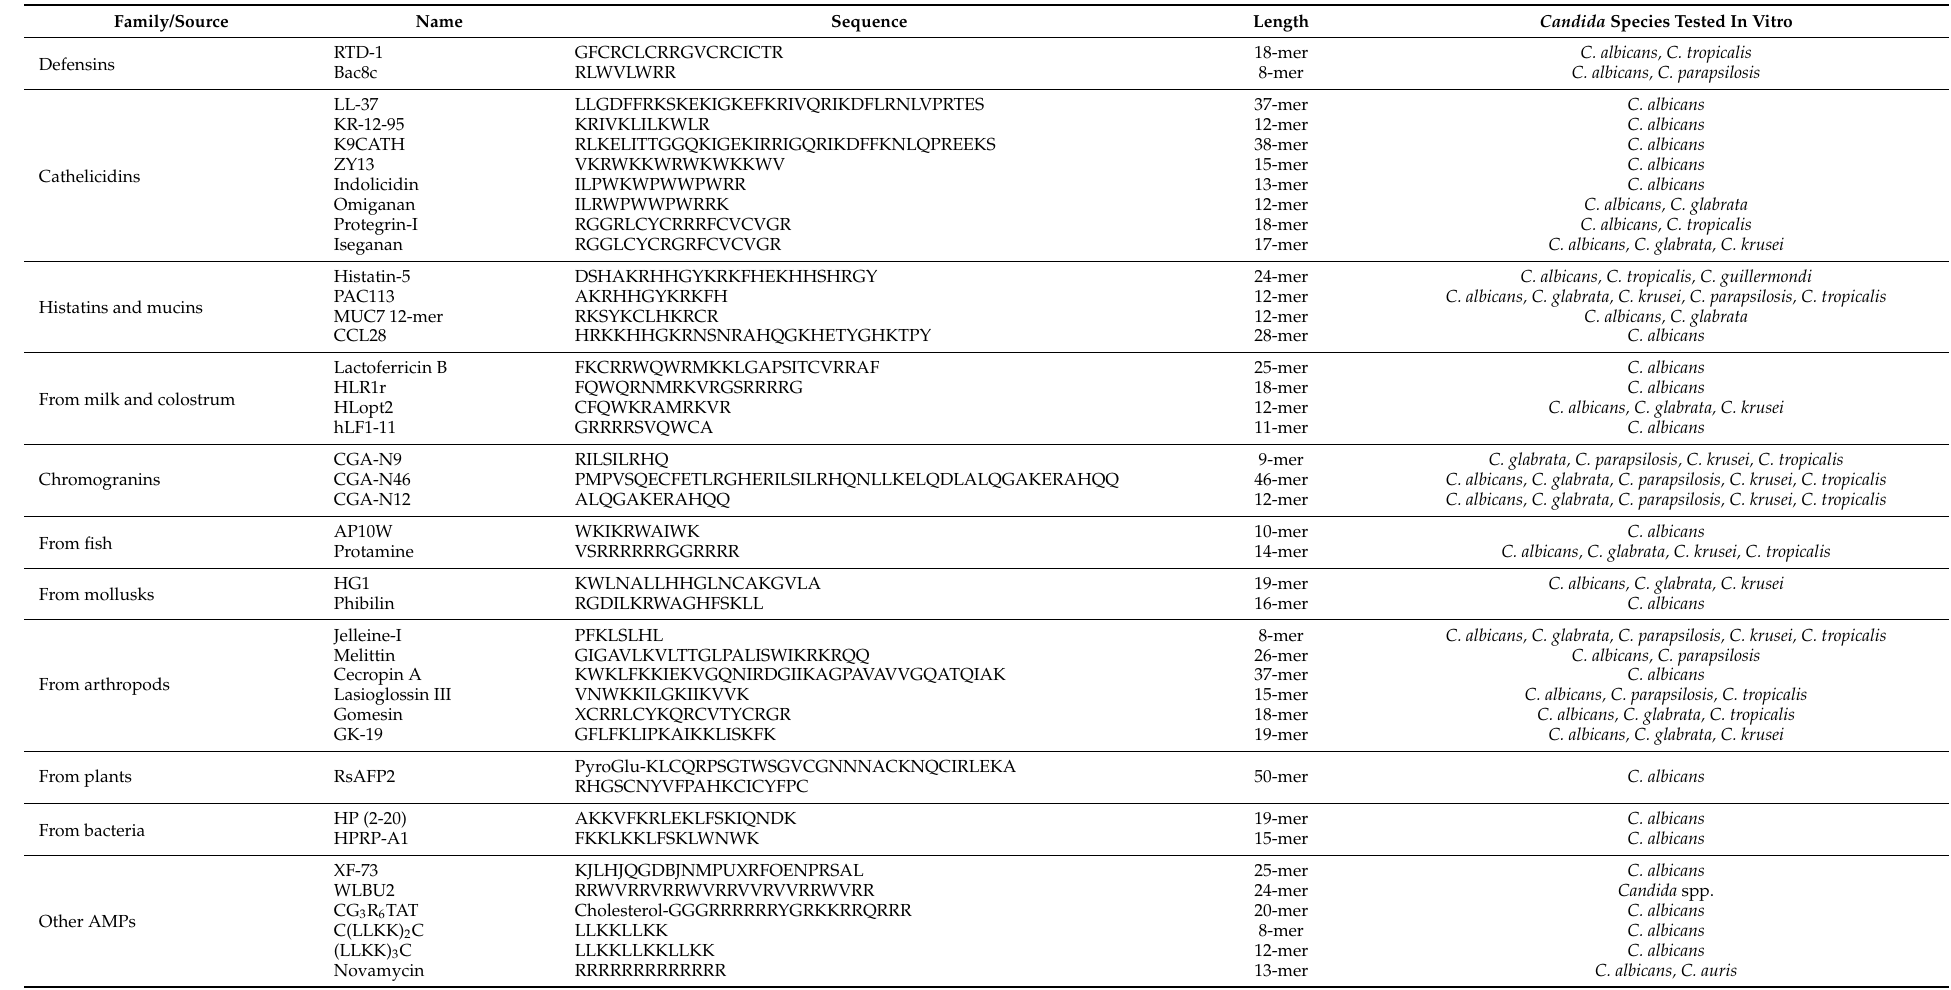
Table 1. Antimicrobial peptides that have been the subject of preclinical or clinical studies against infections caused by Candida species and that have been tested in